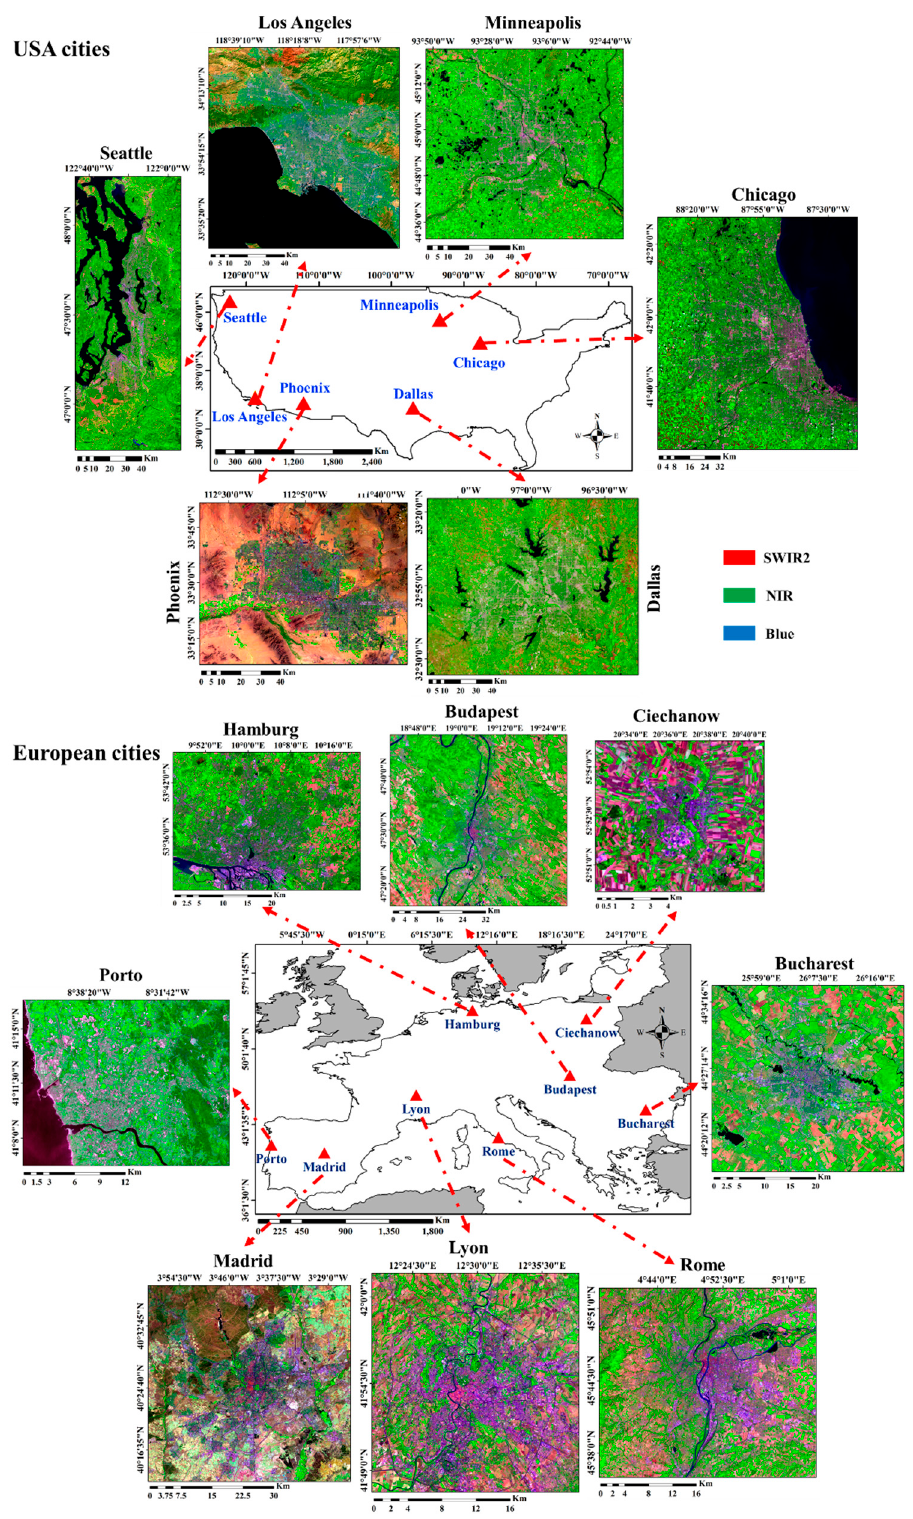
Figure 1. Geographical location and colour-composite images (Blue, near-infrared (NIR), and Short- wave infrared 2 (SWIR2) bands) of selected cities in the USA and Europe.